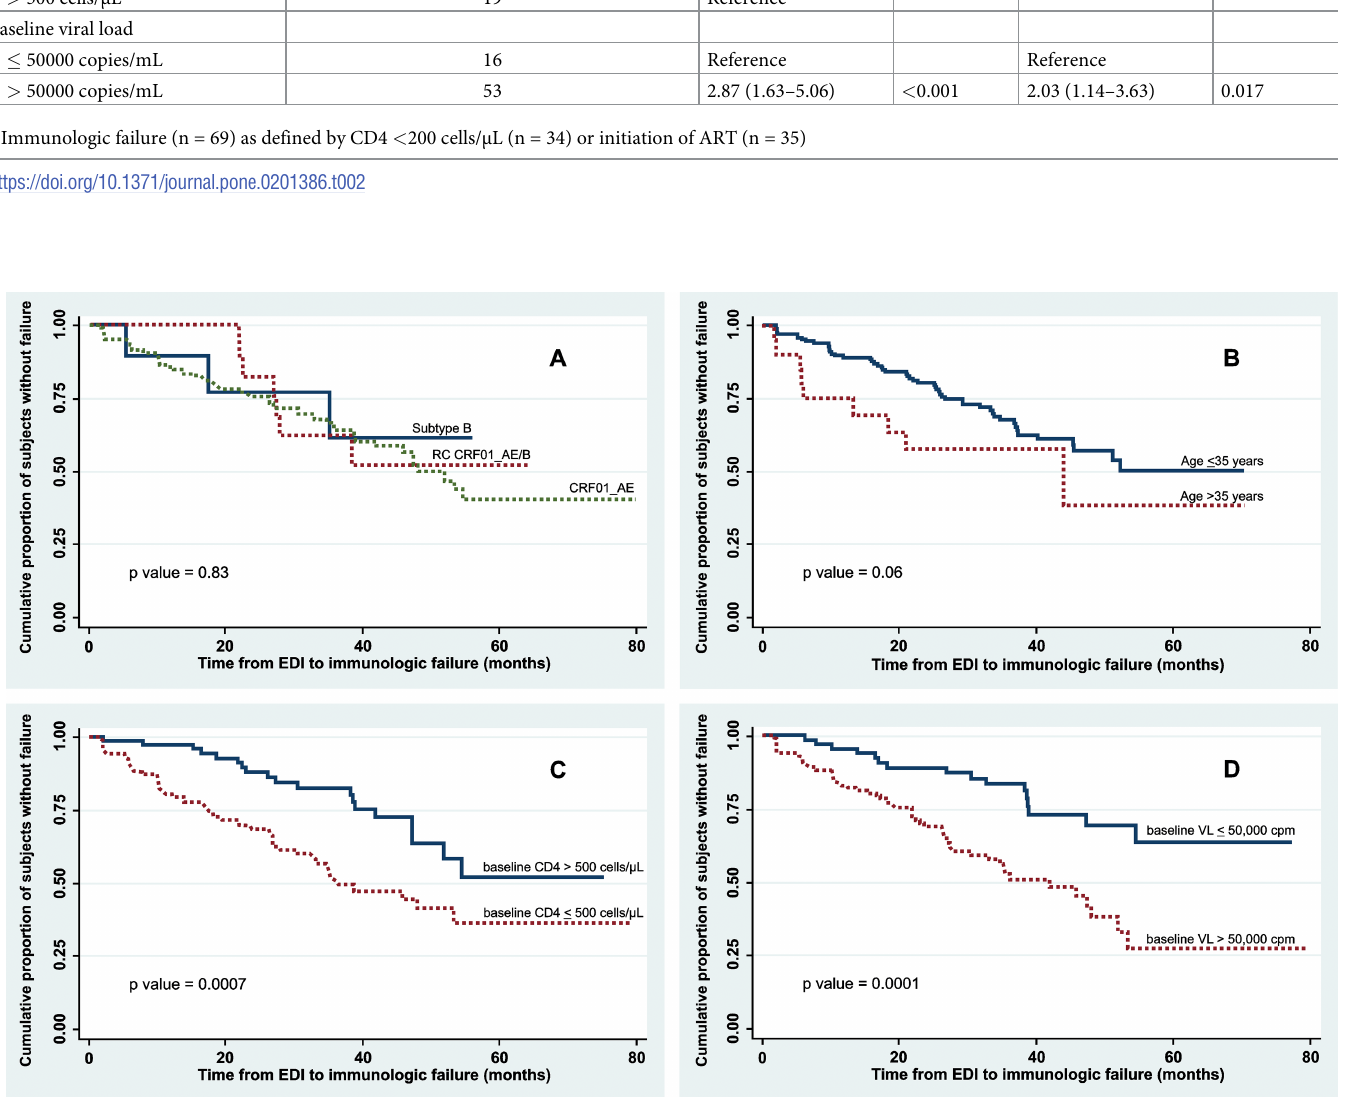
PLOS ONE | https://doi.org/10.1371/journal.pone.0201386 July 31,